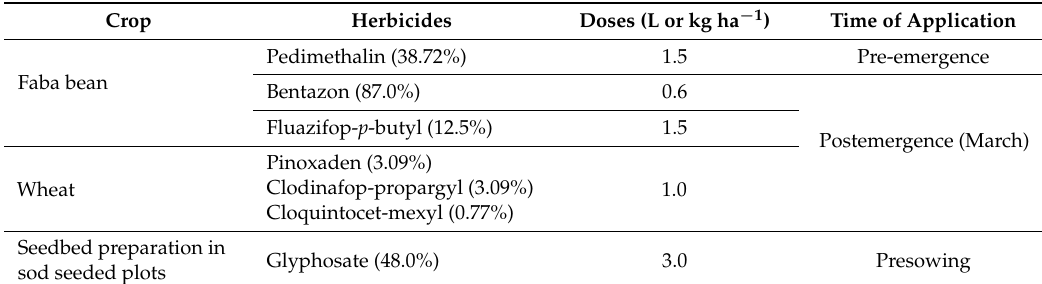
Table 8. Herbicides used for weed management in the